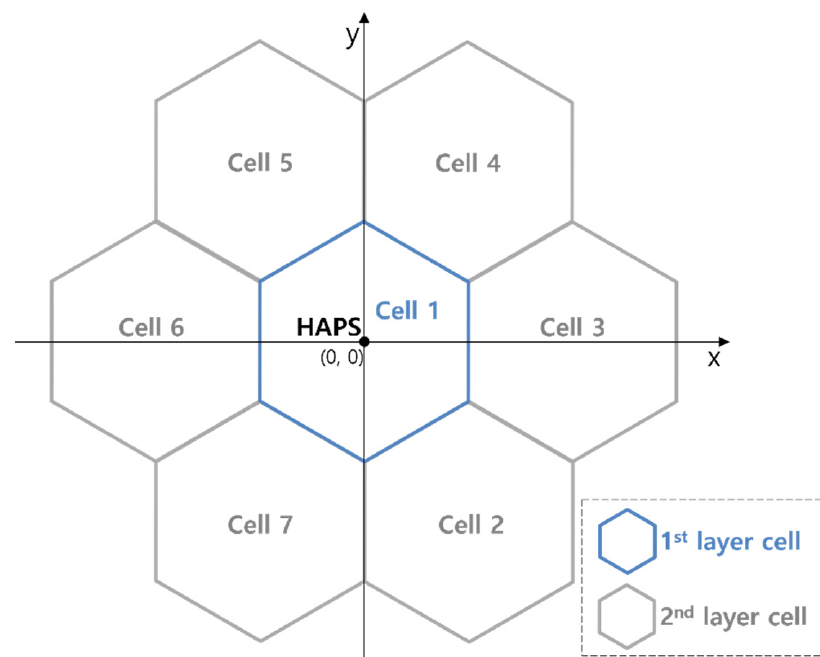
Figure 2. HAPS seven-cell layout.